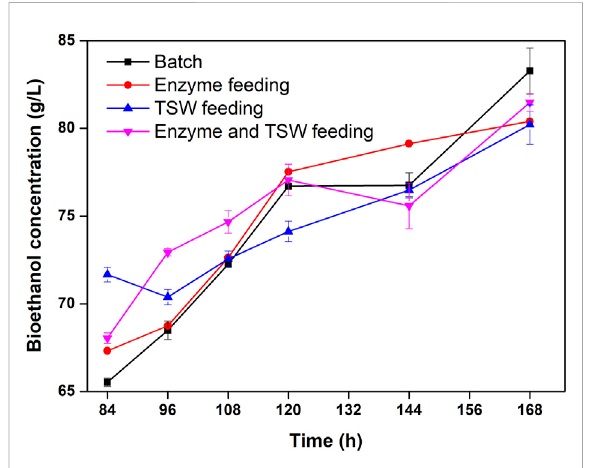
FIGURE 6 Time-course of ethanol concentration during SSCF under different feeding strategies with a feeding period of 24